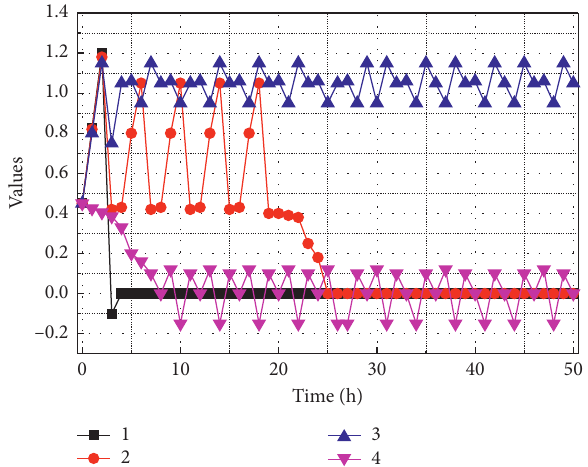
Figure 6: Selection changes under different intensity penalty strategies.